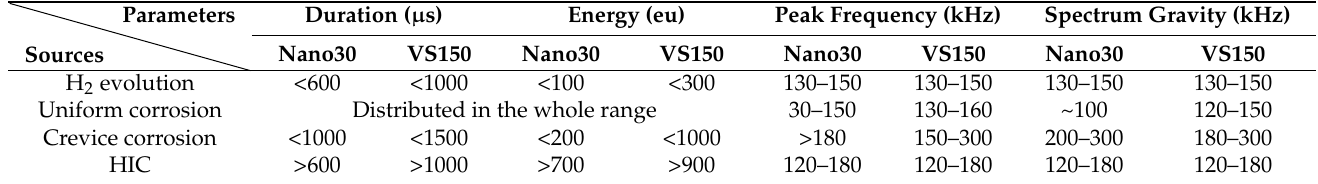
Table 7. Main characteristics of AE signals related to different